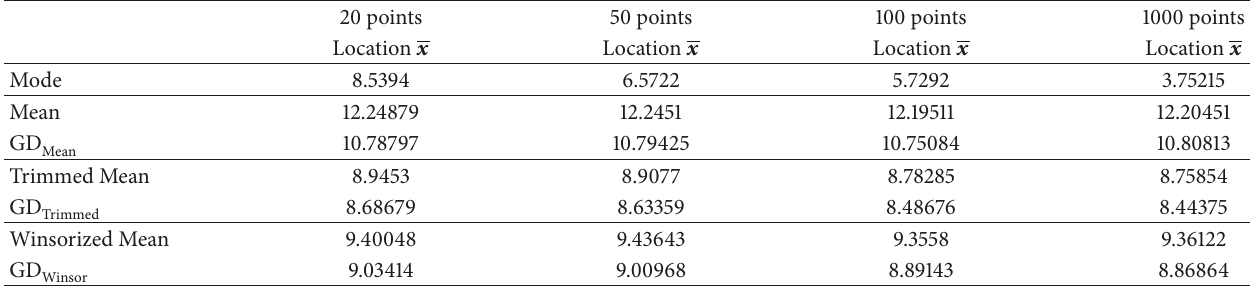
Table 10: Log-normal distributions with 30% noise level.